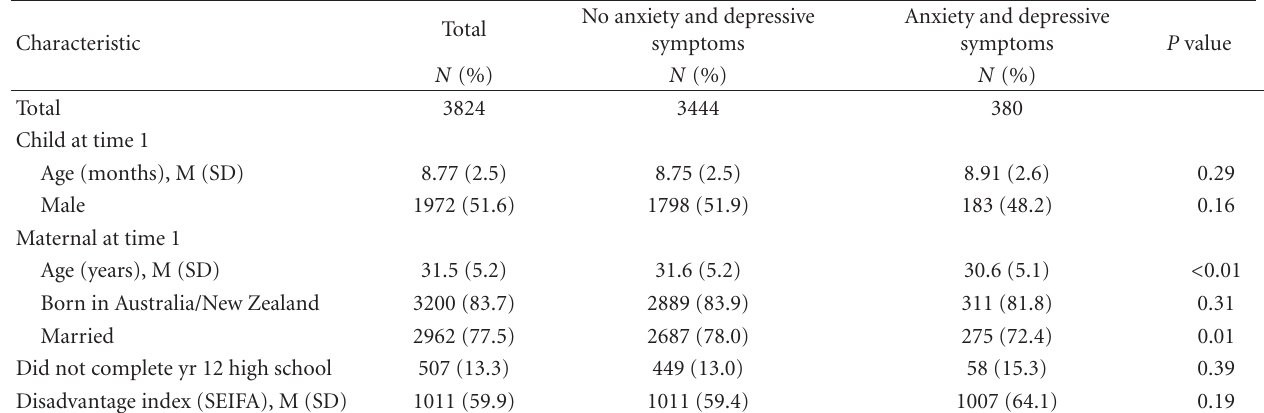
Table 1: Demographic characteristics of participants ( N =